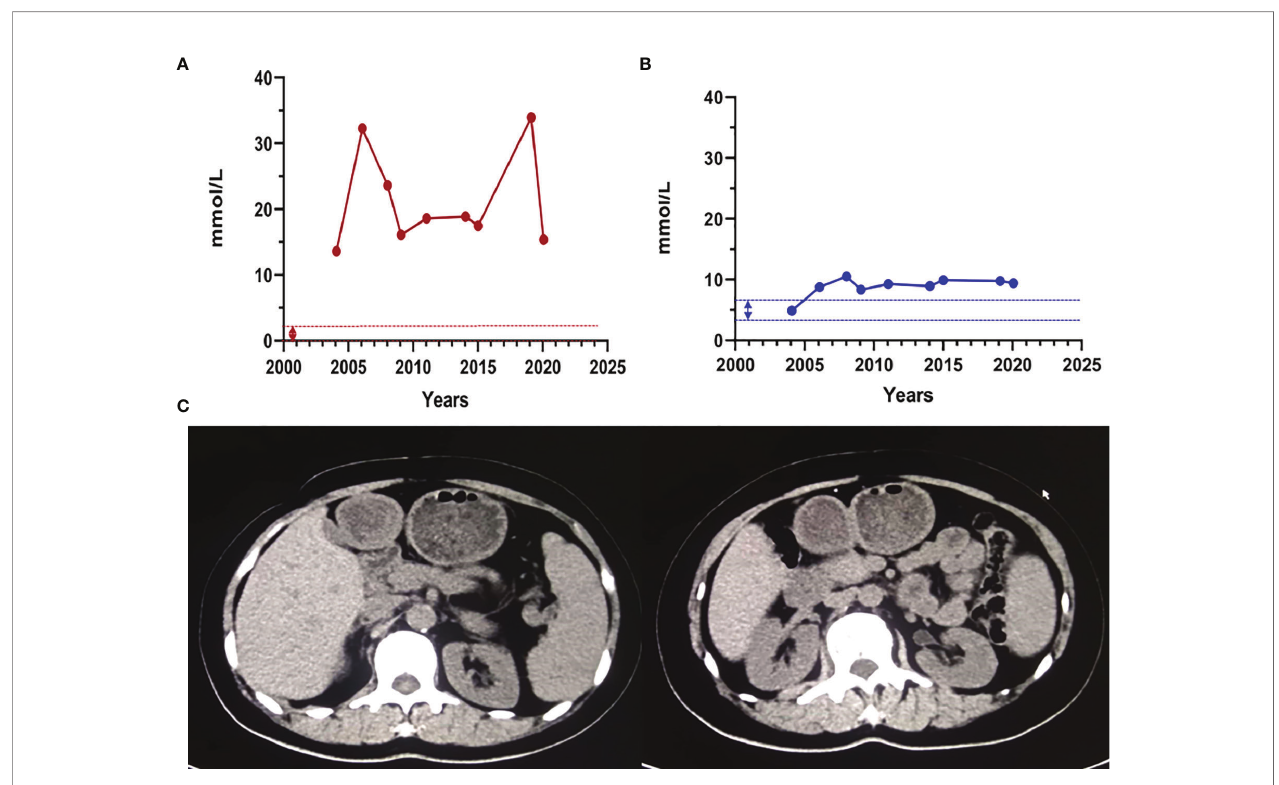
FIGURE 1 | The clinical characteristics of proband 1. (A) The proband 1 triglyceride and total cholesterol levels. The dashed line indicates the normal reference range. Abbreviations: TG, triglycerides; TC, total cholesterol. Normal range: TG: 0.4 – 1.8 mmol/L; TC: 3.6 – 6.2 mmol/L. (B) Abdomen and lower limbs of patient 1. (C) Abdominal CT scan of patient 1. The pancreas was irregular in shape; the liver was normal in shape and size; no abnormal density shadow was observed in the parenchyma; no expansion of the bile ducts in and outside the liver was observed; the shape and size of the gallbladder were fi ne; no abnormal density shadows were found in the gallbladder; and the spleen was normal in shape and